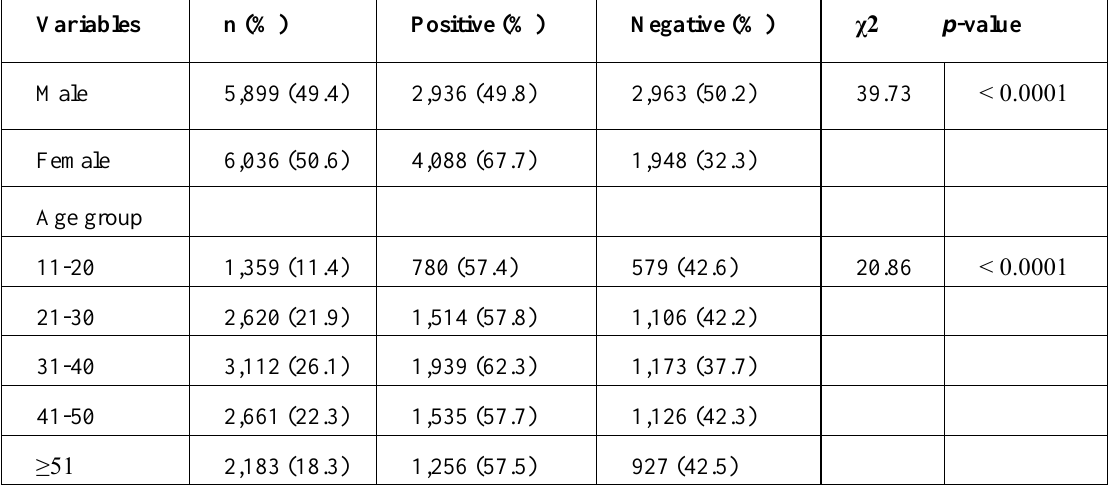
Table 1. Overall seroprevalence of H. pylori among the study subjects from January 2015 to December